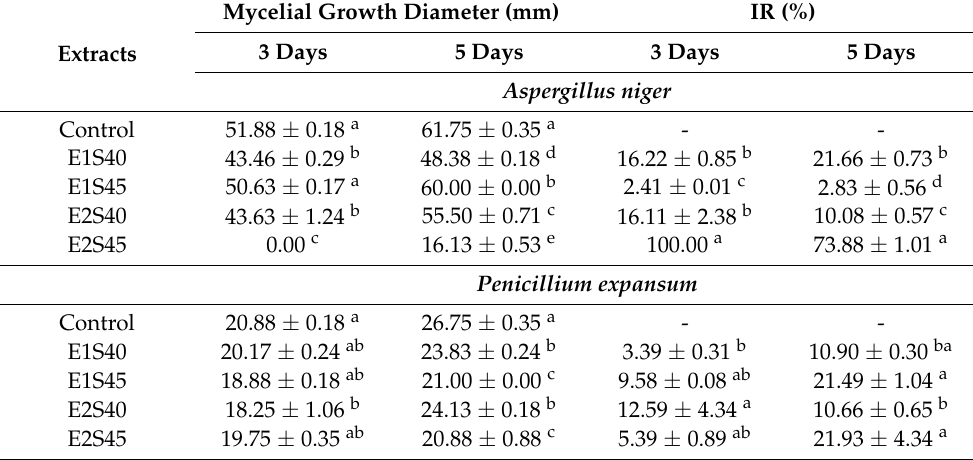
Table 4. Antifungal effect of tested